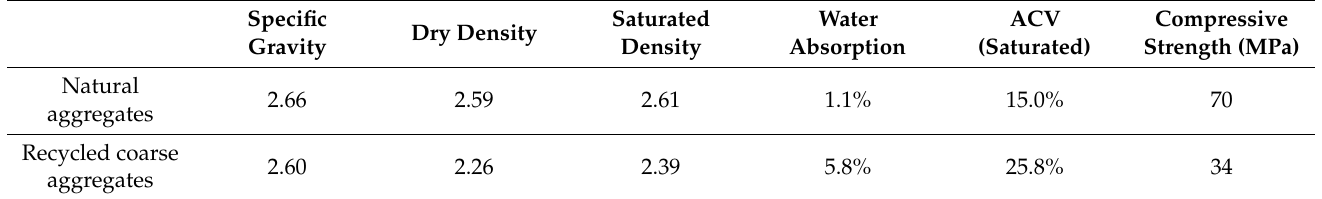
Table 2. Characteristics of aggregates